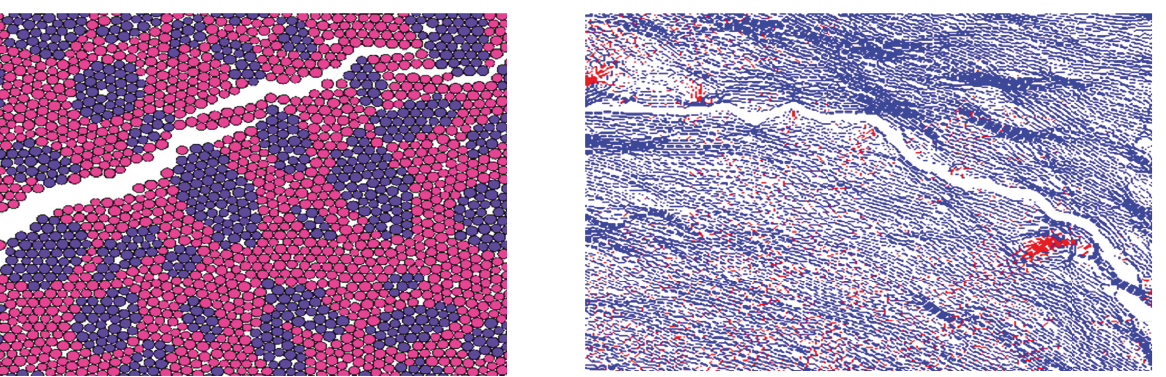
Figure 13: Local macrocrack extension of the lower surface layer.